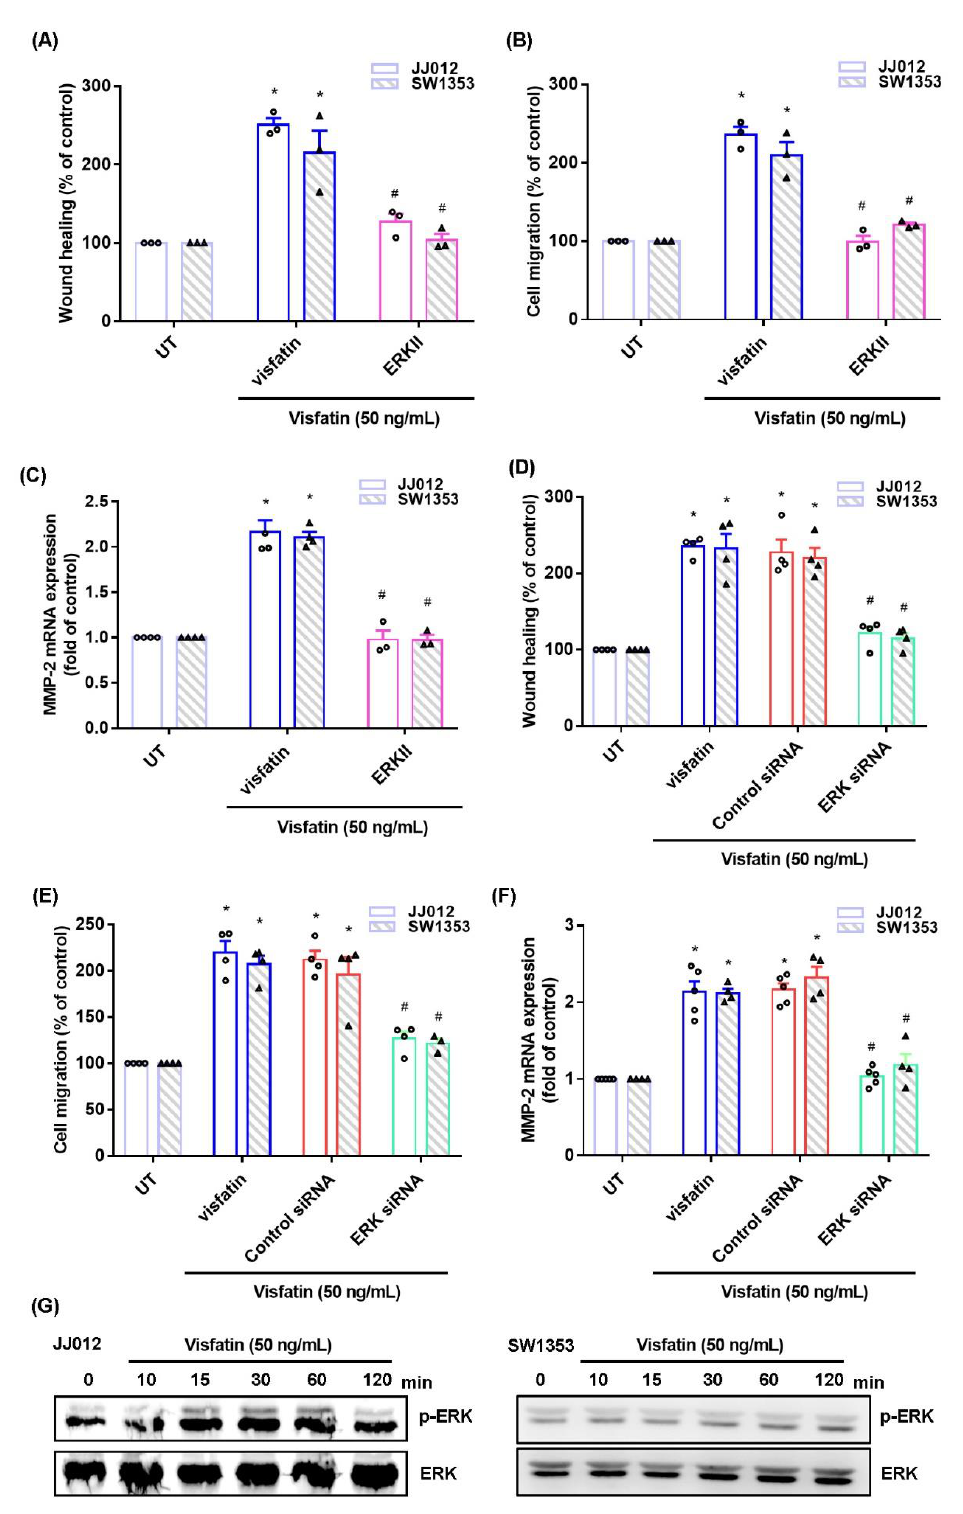
Figure 2. The ERK pathway mediates visfatin-induced MMP-2 expression and cell migration. ( A – F ) Cells were pretreated with an ERK inhibitor (ERK II) or transfected with an ERK siRNA, then stimulated with visfatin. Cell migration and levels of MMP-2 expression were examined by Transwell, wound healing, and qPCR. ( G ) Cells were incubated with visfatin for the indicated time intervals; ERK phosphorylation was examined by Western blot. Quantitative results are expressed as the mean ± SD. All experiments were repeated 3 to 5 times. * p < 0.05 compared with the UT group; # p < 0.05 compared with the visfatin-treated group. UT, untreated